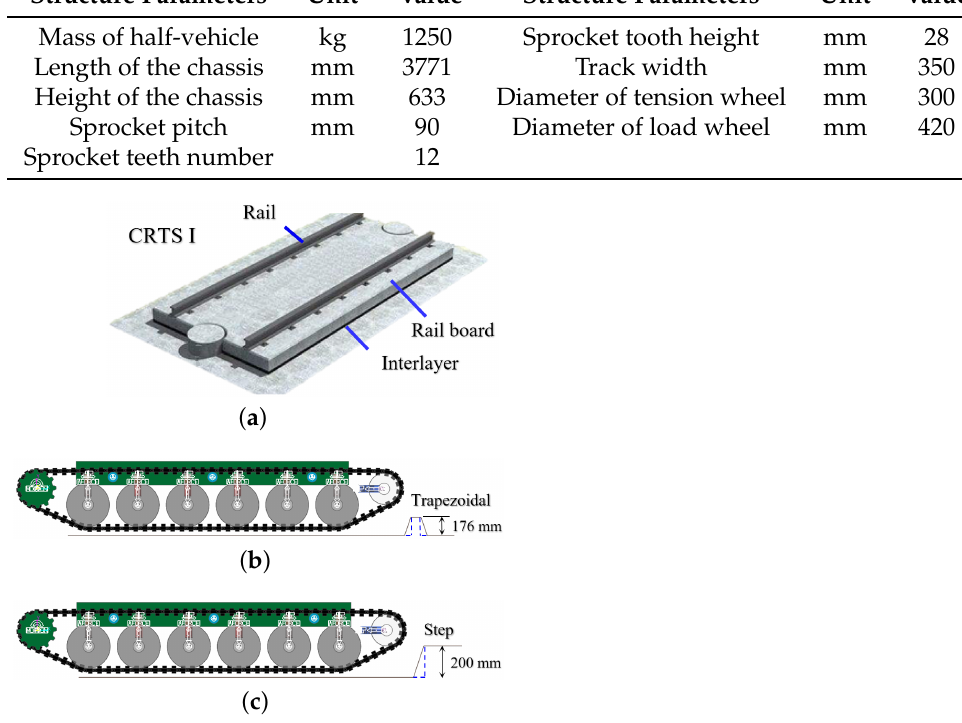
Figure 11. Road surface establishment ( a ) CRTSI railway ( b ) Trapezoidal barrier ( c ) Step